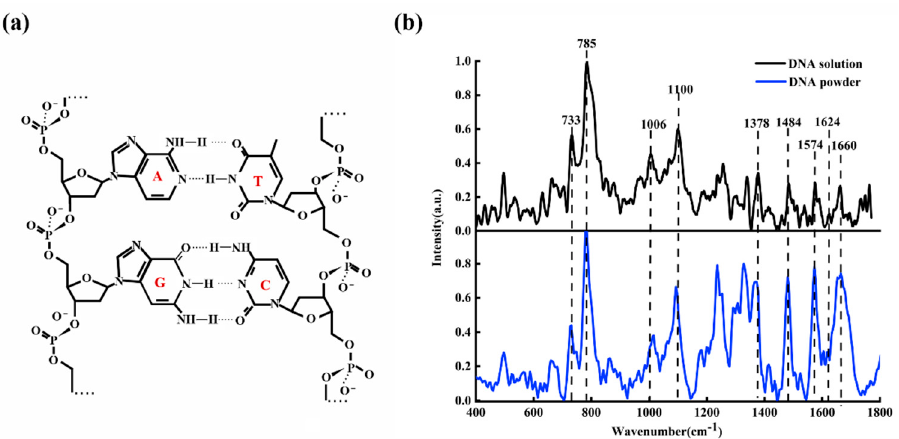
Figure 1. ( a ) The molecular structure of ctDNA; ( b ) Raman spectra of ctDNA fiber (blue line) and ctDNA solution (9.8 × 10 − 2 M, black